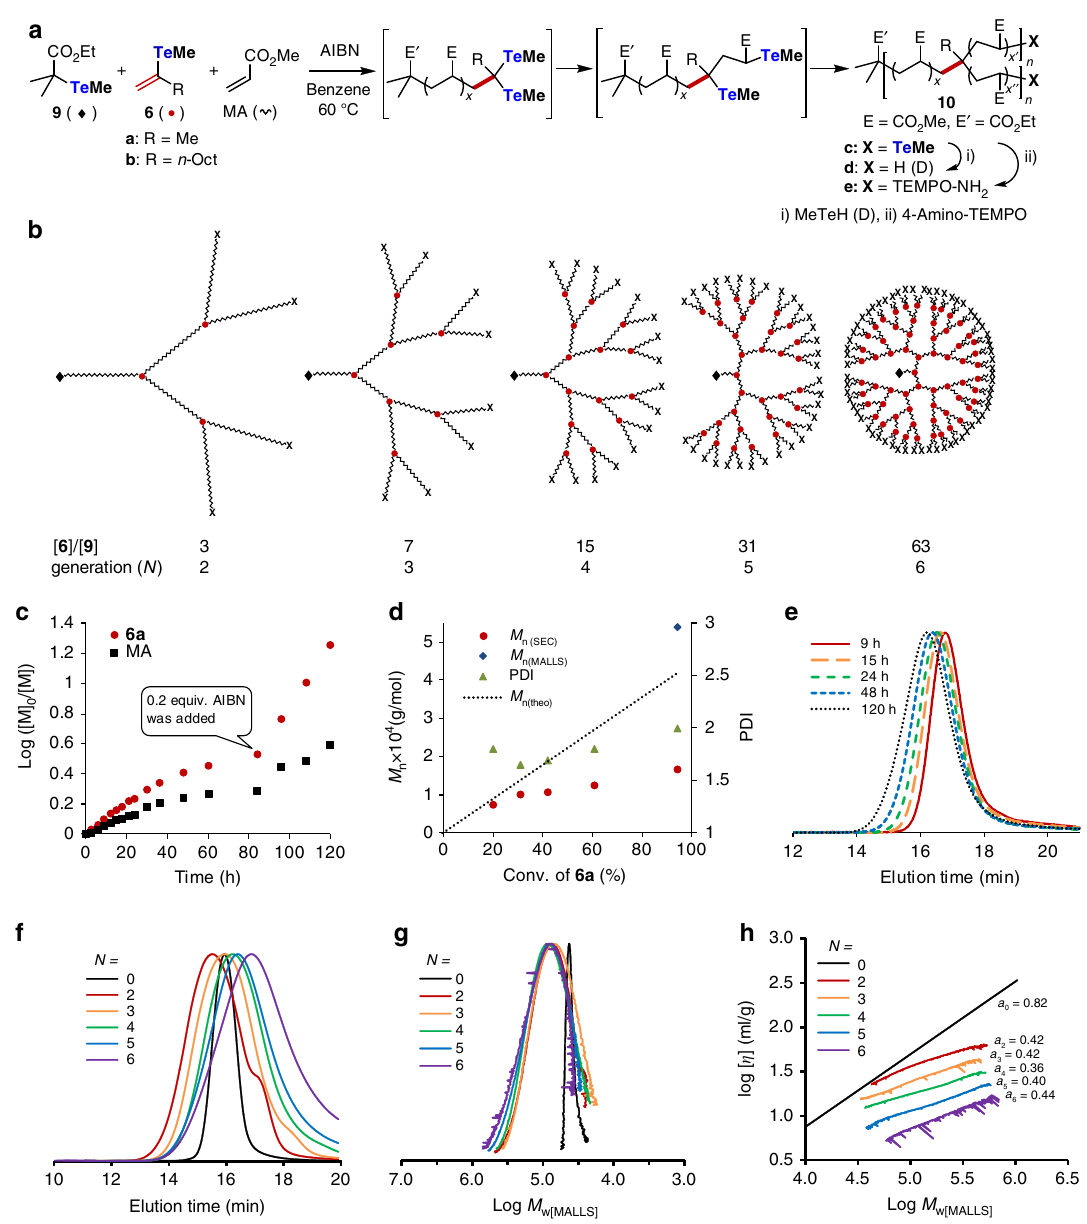
Fig. 2 Synthesis and characterization of dendritic hyperbranched polymers (HBPs). a Formation of the HBPs by the copolymerization of 6 and methyl acrylate (MA) in the presence of an organotellurium chain-transfer agent 9 . b Schematic structures of ideal polymer products produced at [ 6 ]/[ 9 ] ratios of 3, 7, 15, 31, and 63, corresponding to dendritic generations N of 2, 3, 4, 5, and 6, respectively. c Time evolution of the consumption of 6a and MA determined by 1 H NMR analysis for the synthesis of the sixth generation (Table 1, run 5). Additional AIBN (0.2 equiv.) was added after 84 h. d Correlation among the monomer conversion, number average molecular weight, and PDI for the synthesis of the sixth generation (Table 1, run 5). e Time evolution of the SEC traces from 9 to 120 h. f SEC traces observed by a refractive index (RI) detector. g Corrected SEC traces with the weight average molecular weight determined by MALLS ( M w[MALLS] ) and peak intensity determined by an RI detector. h Mark – Houwink – Kuhn – Sakurada plot for linear PMA (dendritic generation N = 0) and copolymers with N = 2, 3, 4, 5, and 6 (Table 1, runs 1 – 6)